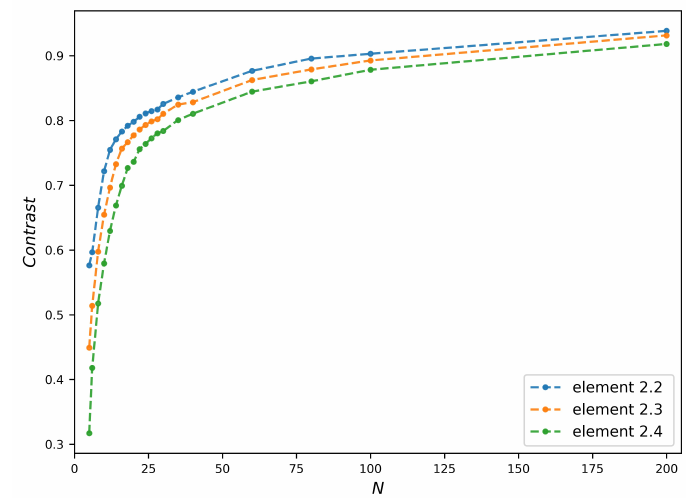
Figure 9. Contrast plots measured from the images formed by refractive lens: For the sake of clarity, the horizontal axis displays the number of zones of the FZP having the same NA than the refractive lens. Moreover, the images are simulated under the same conditions as for Figure